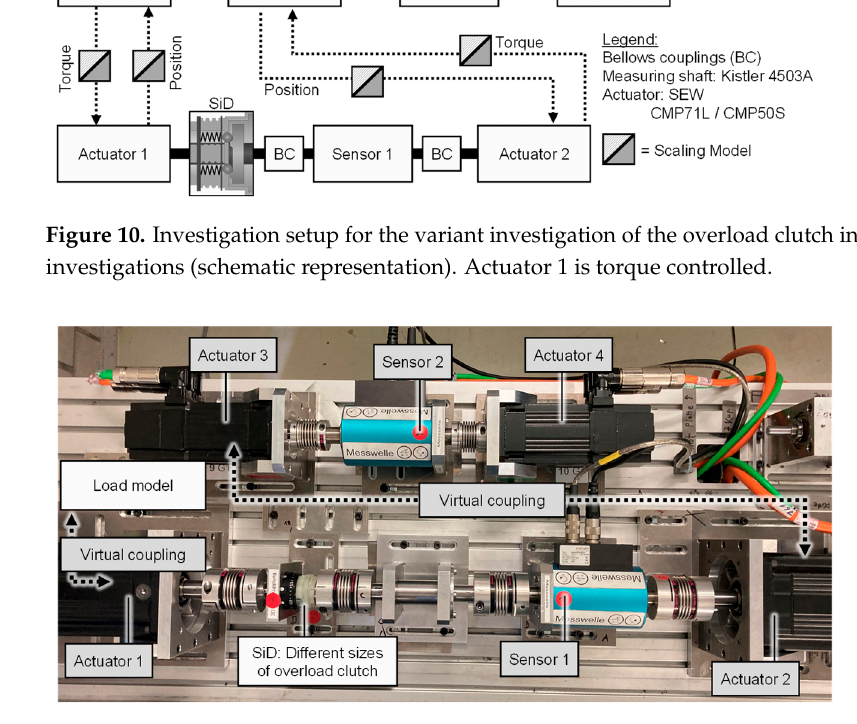
Figure 10. Investigation setup for the variant investigation of the overload clutch in scaled test bench investigations (schematic representation). Actuator 1 is torque controlled.